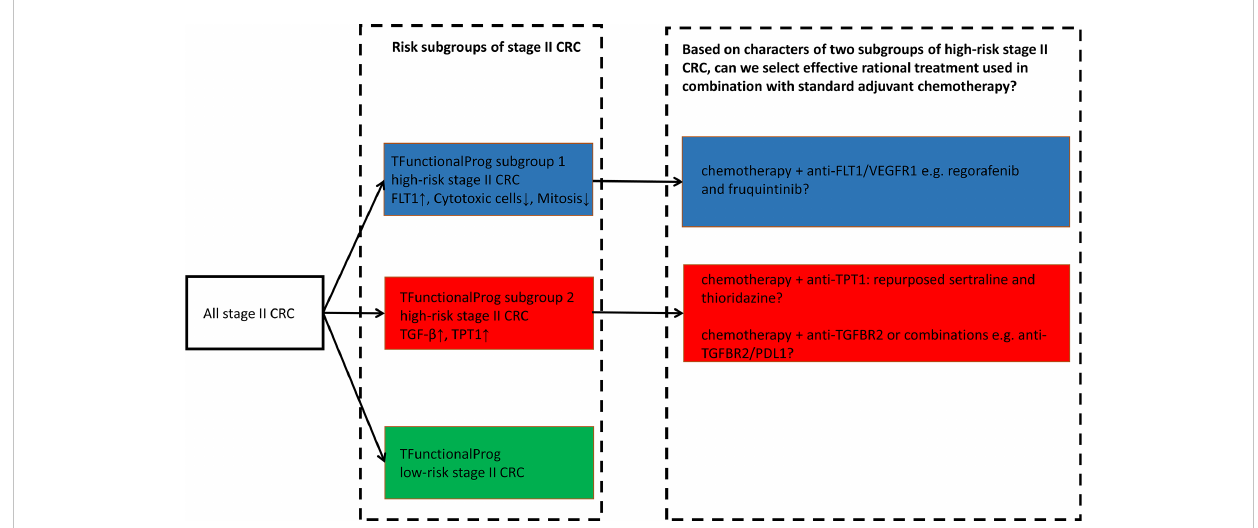
FIGURE 5 TFunctionalProg subgroups of the risk of recurrence of stage II CRC: low-risk group (green, LR), high-risk subgroup 1 (blue, HR1) and high-risk subgroup 2 (red, HR2). Different tumor characters and tumor microenvironments in TFunctionalProg high-risk subgroup 1 and TFunctionalProg high-risk subgroup 2 suggest that standard chemotherapy may be combined with different rational personalized treatment options to increase the bene fi t of adjuvant treatment in stage II CRC. This scheme proposes three drug combinations for further